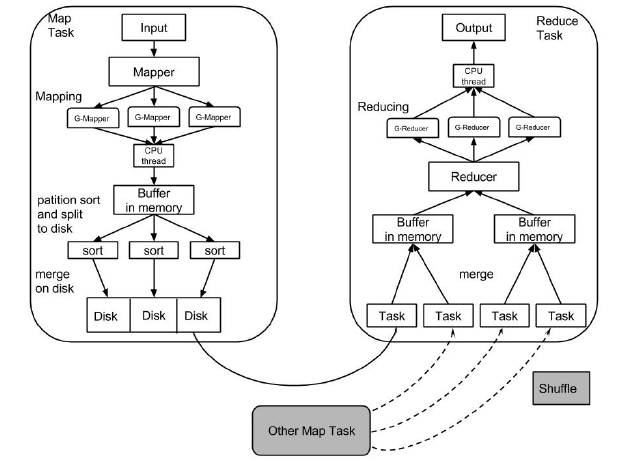
Fig. 1. MapReduce in